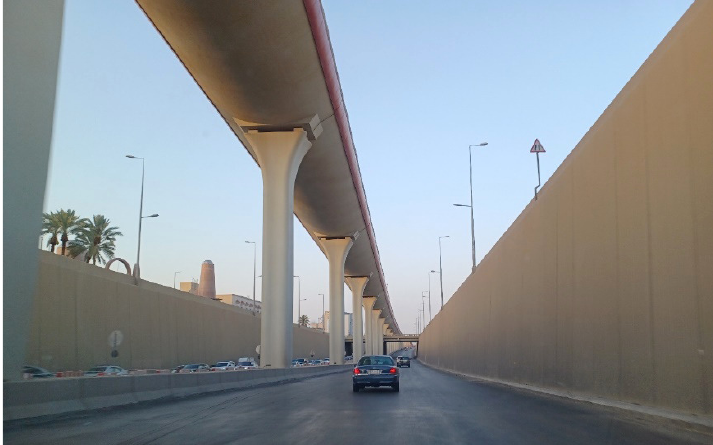
Figure 5. The Riyadh Metro: Work in progress for the metro